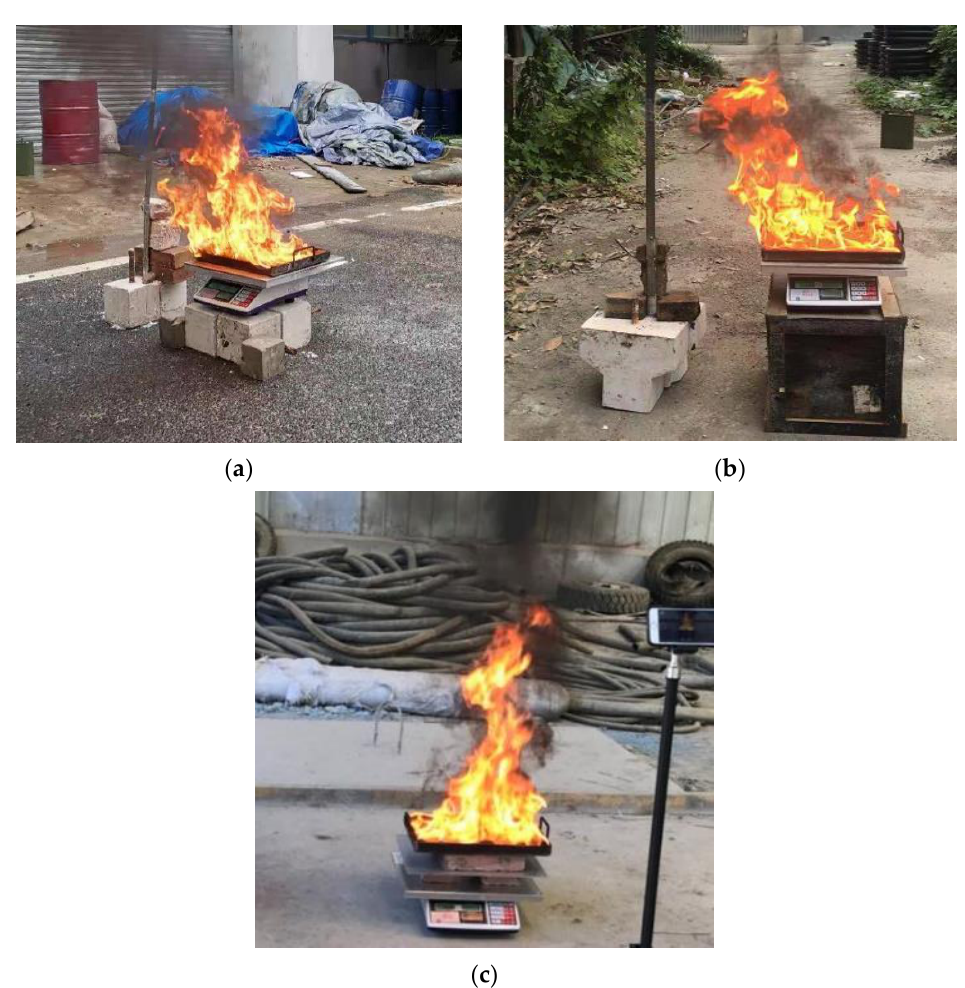
Figure 6. Flame height in three experimental sites. ( a ) Chengdu, Sichuan; ( b ) Kunming, Yunnan; ( c ) Lhasa, Tibet.